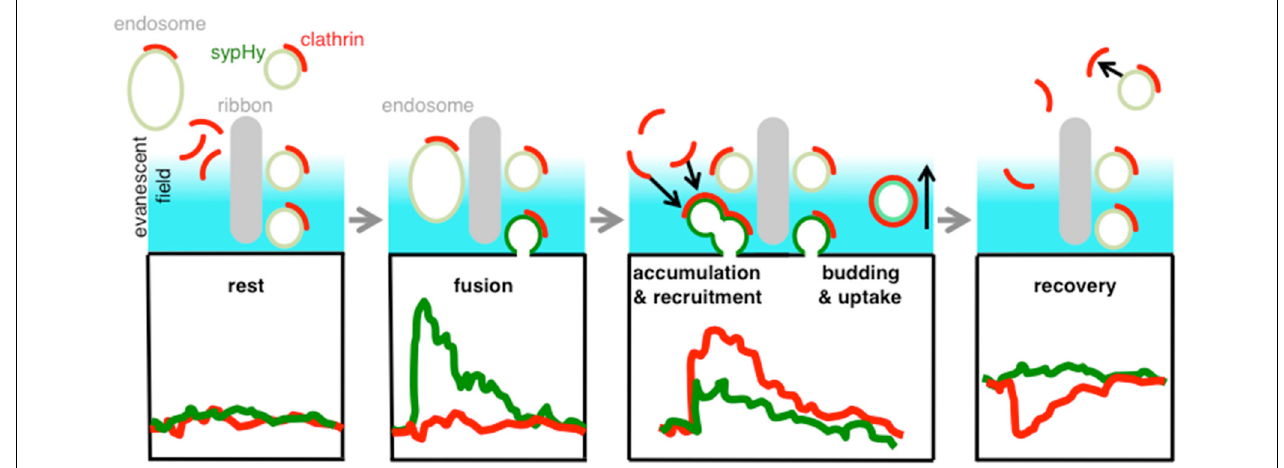
FIGURE 7 | Schematic model. Clathrin is immobilized on docked-vesicles and endosomes/cisternae at the active zone. When a vesicle fuses we observe a clear SypHy signal (green trace) but no net signal of clathrin (red), because the net recruitment and accumulation occurs while the sypHy signal